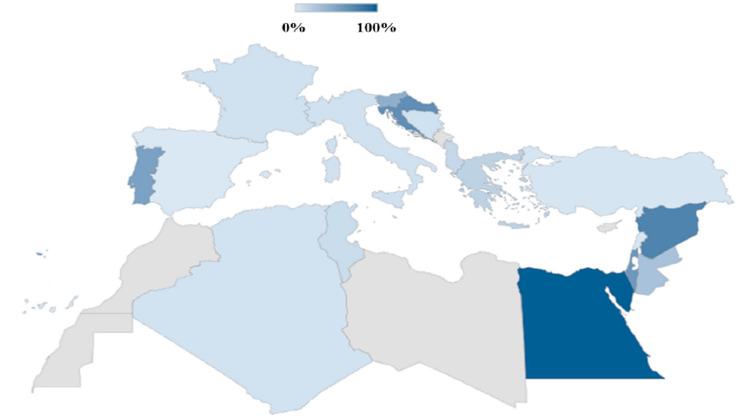
Figure 6. Dependency ratio by Country, 2017 [17].